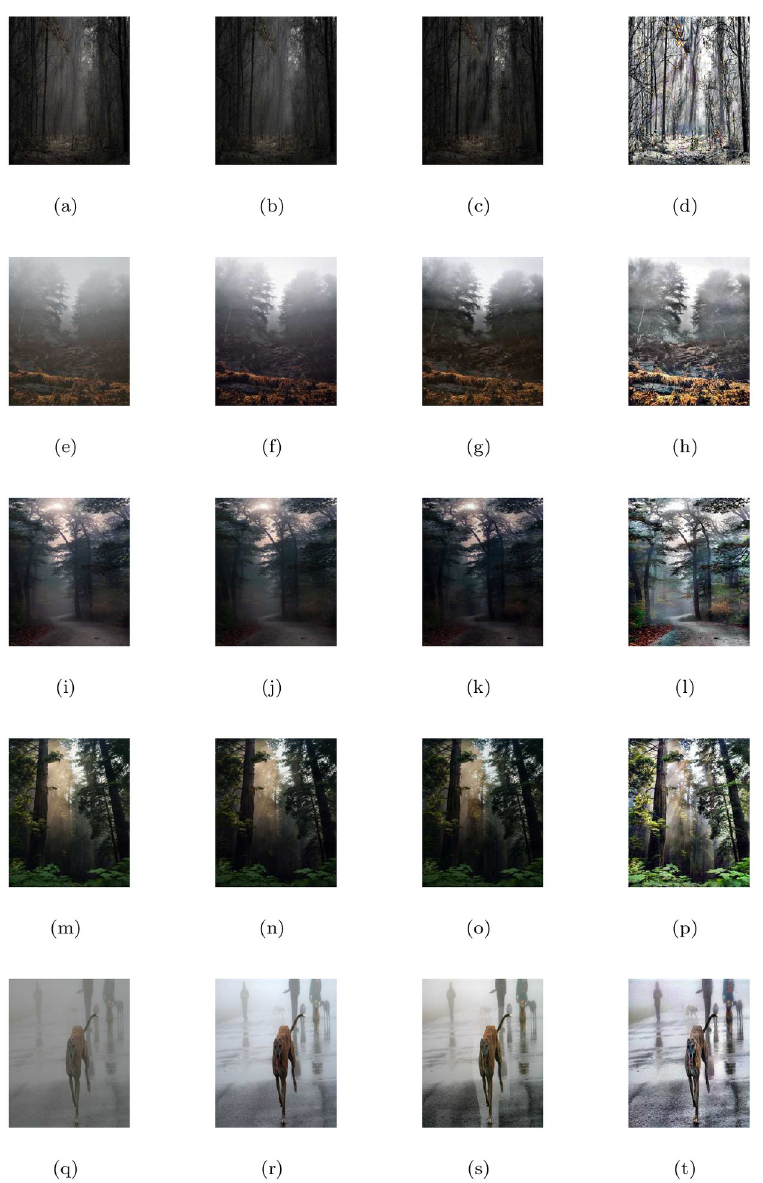
Fig 9. Restoration performance of the proposed model (M3) in comparison with M1 and M2. From L to R columns represent the given images, Cho et al. [9] (M1) results, He et al. [4] (M2) results and proposed model results,